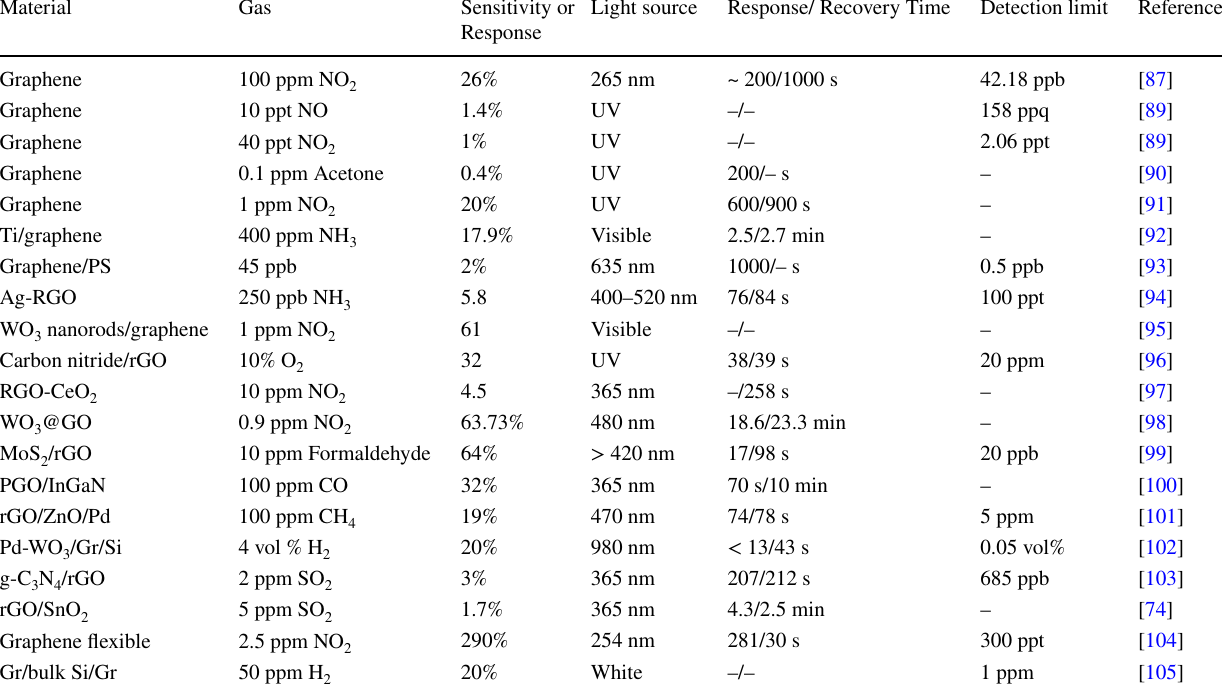
Table 2 Summary of graphene-based gas sensors to various gases under photoactivation at room temperature